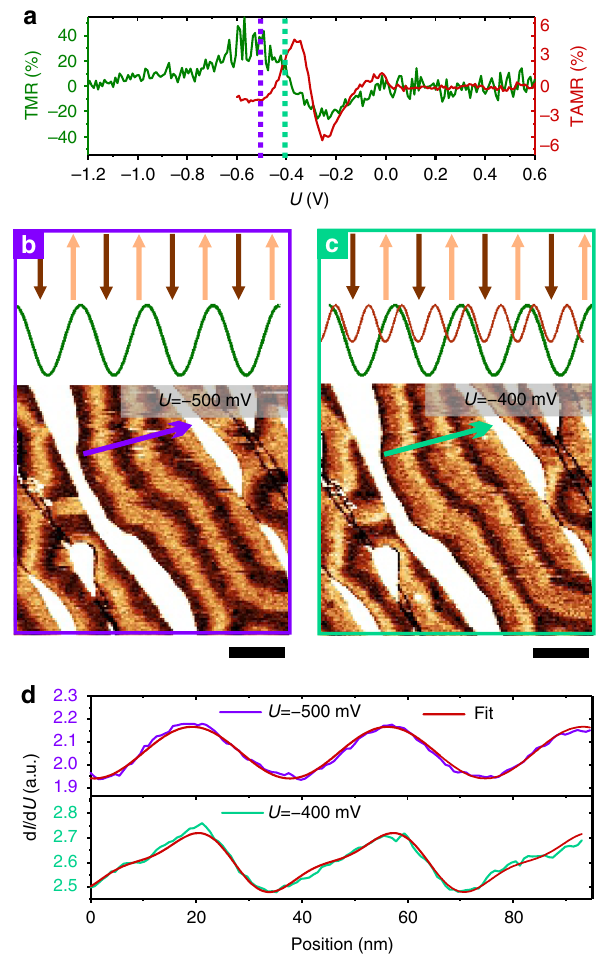
Fig. 2 Chirality of the spin spiral. a Voltage dependency of the TMR (green curve — Δ U rms = 20 mV) and TAMR (red curve — Δ U rms = 10 mV). b , c bottom: d I /d U spin polarized map taken at U = − 500 mV ( b ) and − 400 mV ( c ) ( I = 1 nA, Δ U = 40 mV, scale bar is 50 nm, tip spin rms polarization was at 47° away from the normal direction). Top: sketches of the magnetization and the corresponding d I /d U pro fi les perpendicular to the stripes due to TMR effect (green curve) and TAMR effect (red curve). d Experimental d I /d U pro fi le plotted along the violet arrow in b and the green arrow in c . Red curves superimposed on the experimental pro fi les are fi ts assuming a contribution of TMR only for the top panel and a combination between TMR and TAMR for the bottom